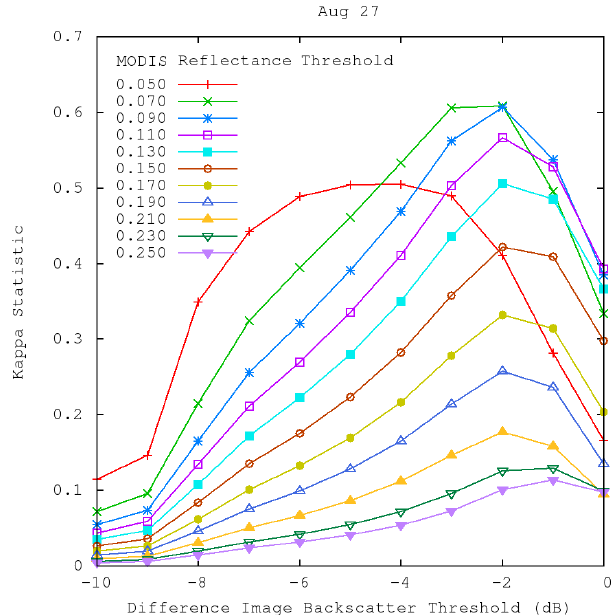
Fig. 11. κ statistic calculated for individual classifications of flood- ing on 10 August 2010, based upon 1σ 0 thresholds ranging from − 10 to 0dB. The series represents corresponding MODIS Band 6 reflectance thresholds used in the reference image, ranging from 0.05 to 0.25.